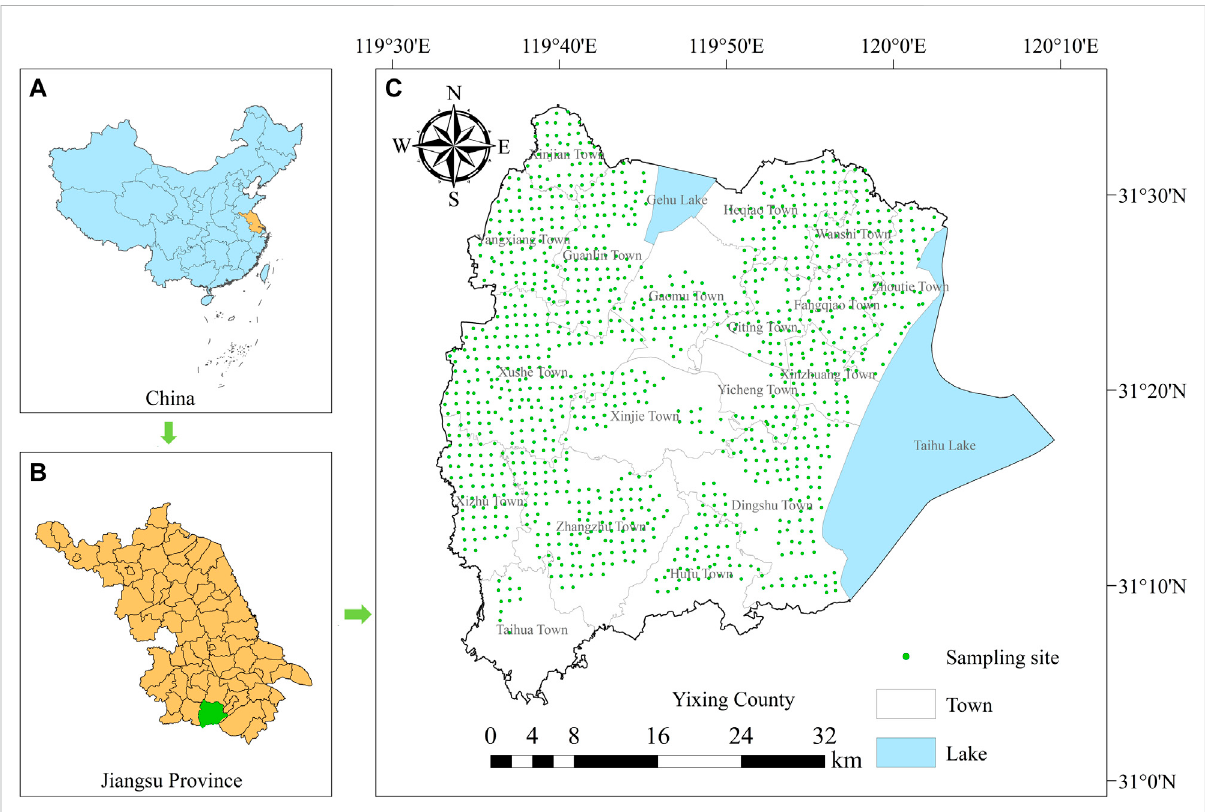
FIGURE 1 Locationofthestudyareaanddistributionofsamplingsites. (A,B) showthelocationofthestudyarea(YixingCounty)inJiangsuProvince,China, and (C) shows the administrative division of Yixing County and the distribution of sampling